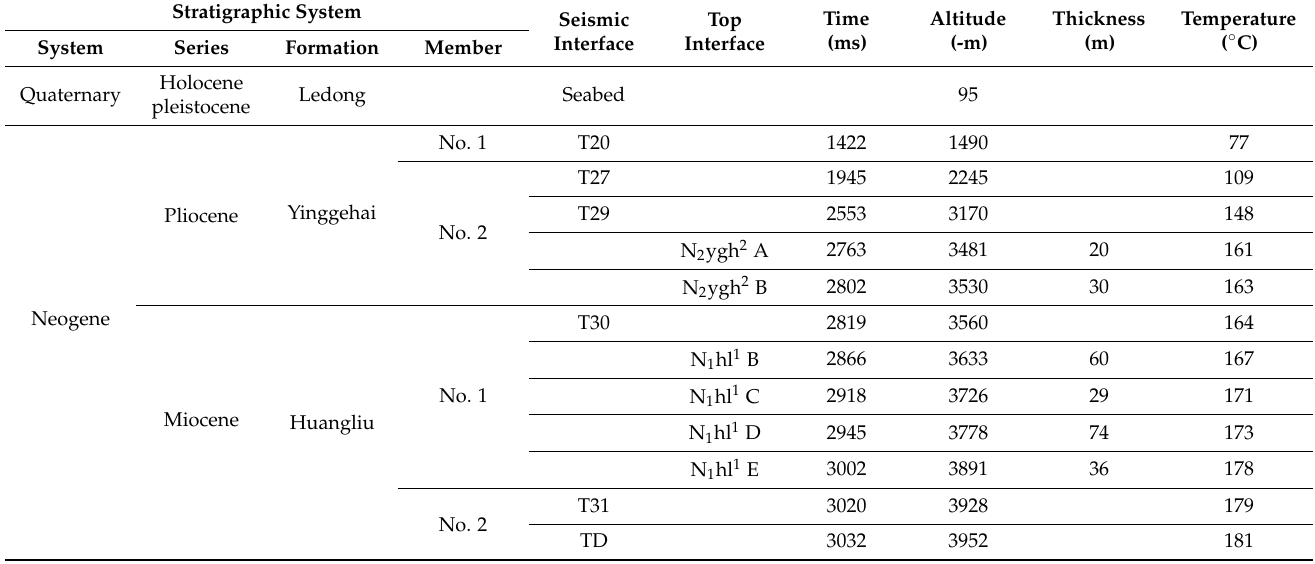
Table 1. Basic technical data of the individual geological